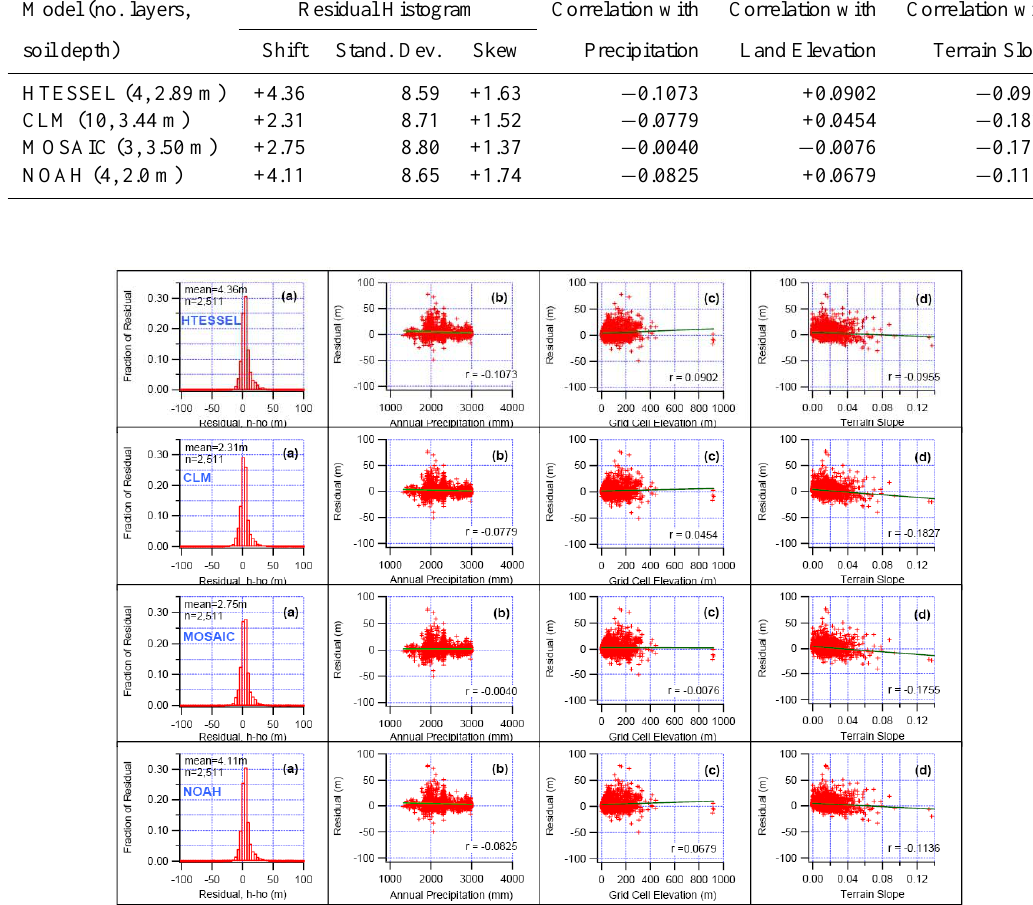
recharge, is reasonable. However, recharge is calculated